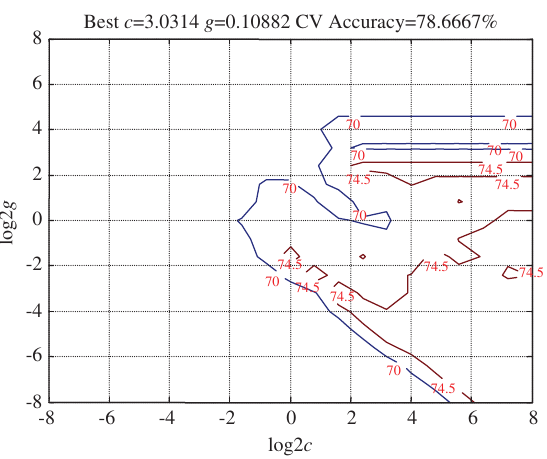
Figure 3: The Optimized Result of the Second Group of Experiments.